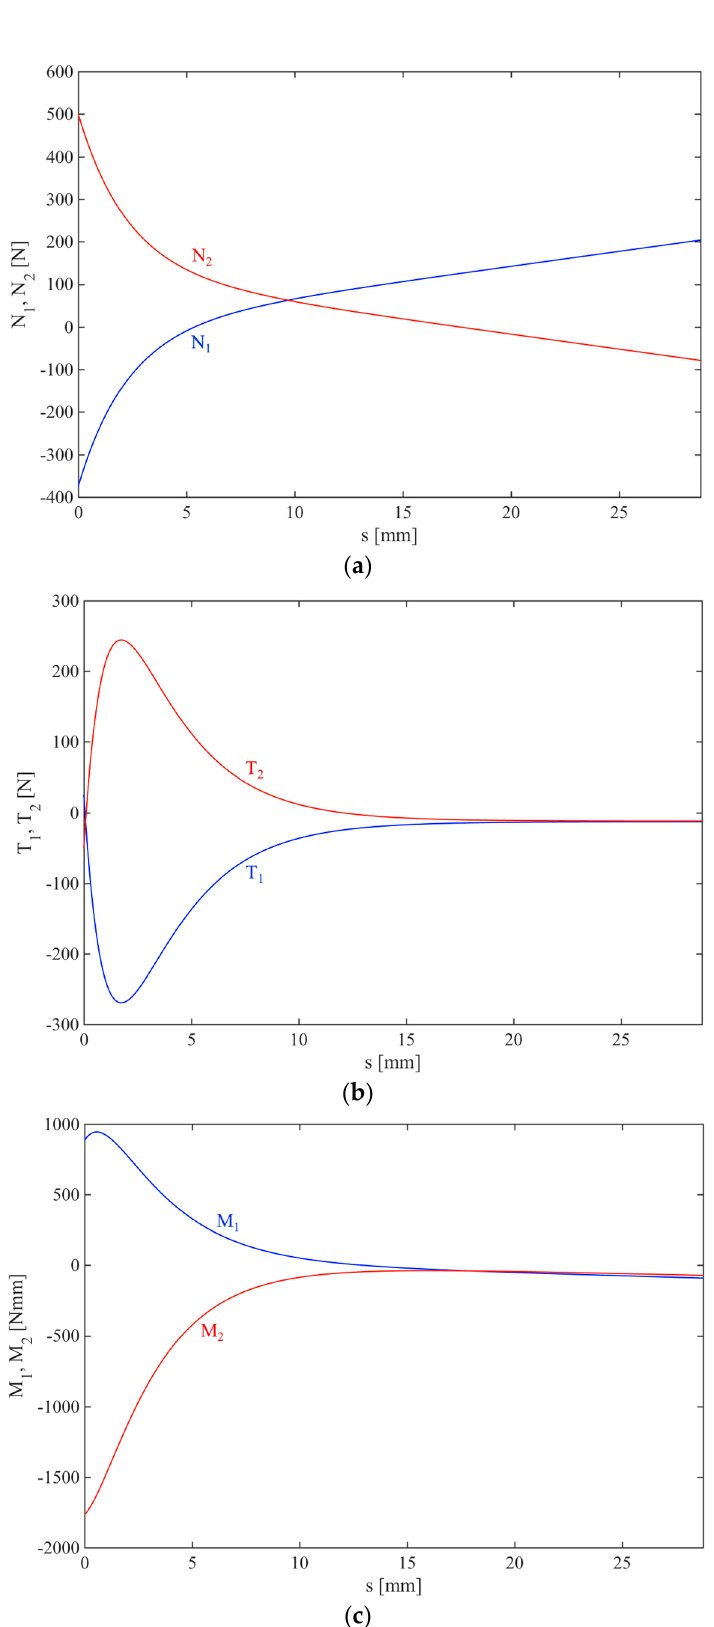
Figure 23. Composite specimen: ( a ) Axial force; ( b ) Shear force; ( c ) Bending moment.